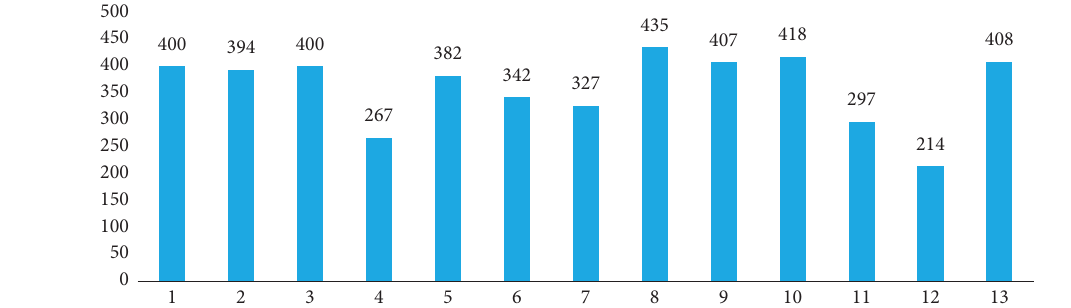
Figure 4: Category II: cognitive development-content mastery.